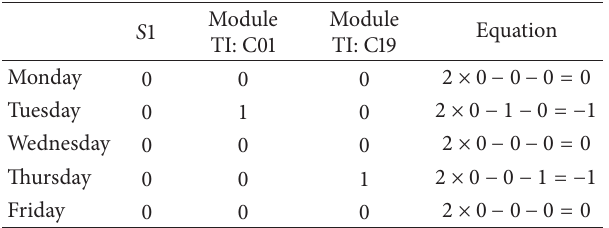
Table 5: 𝑆2 : variable equals 0.